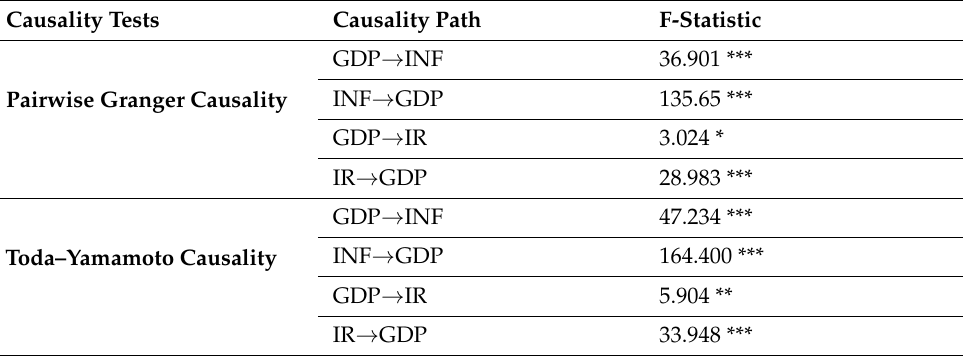
Table 4. Causality